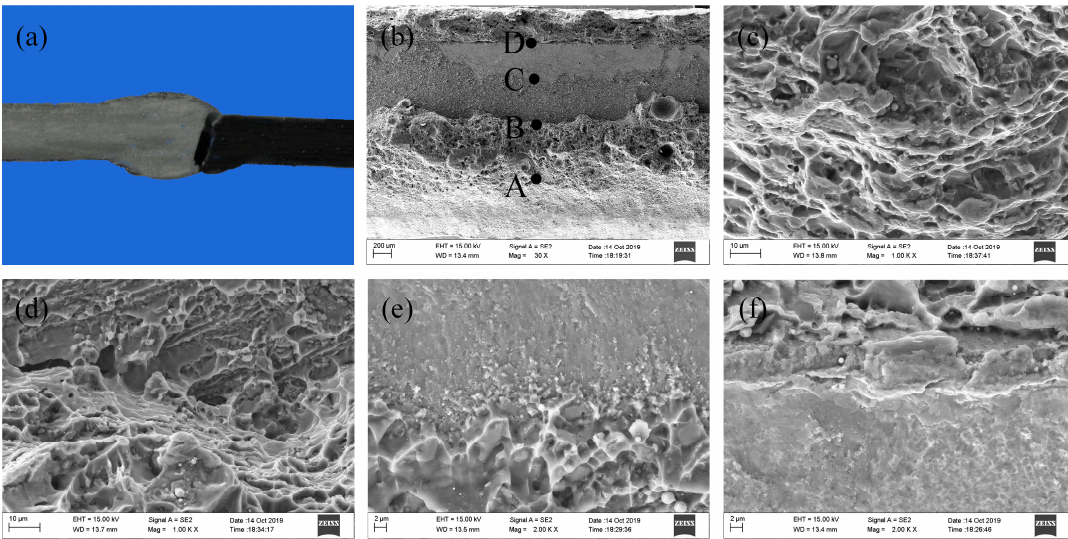
Figure 16. Macro ‐ fracture location and micro ‐ fracture morphologies of the tensile specimen: ( a ) Figure 16. Macro-fracture location and micro-fracture morphologies of the tensile specimen: ( a ) Macro- Macro ‐ fracture location; ( b ) Micro ‐ fracture morphology; ( c ) Larger version of domain A; ( d ) Larger fracture location; ( b ) Micro-fracture morphology; ( c ) Larger version of domain A; ( d ) Larger version of version of domain B; ( e ) Larger version of domain C; ( f ) Larger version of domain D. domain B; ( e ) Larger version of domain C; ( f ) Larger version of domain